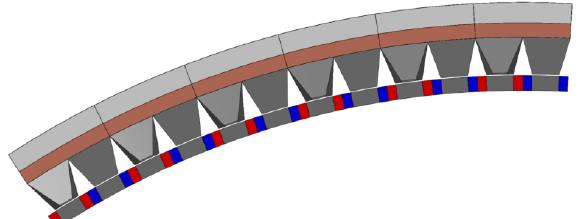
Figure 2: One phase of a claw pole TFPM motor